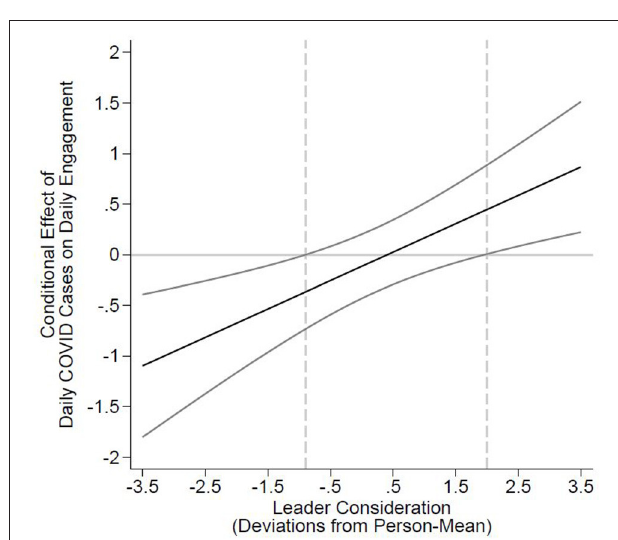
FIGURE 3 | Johnson–Neyman regions of significance for the conditional relation between daily COVID-19 cases and daily engagement at realized values of leader